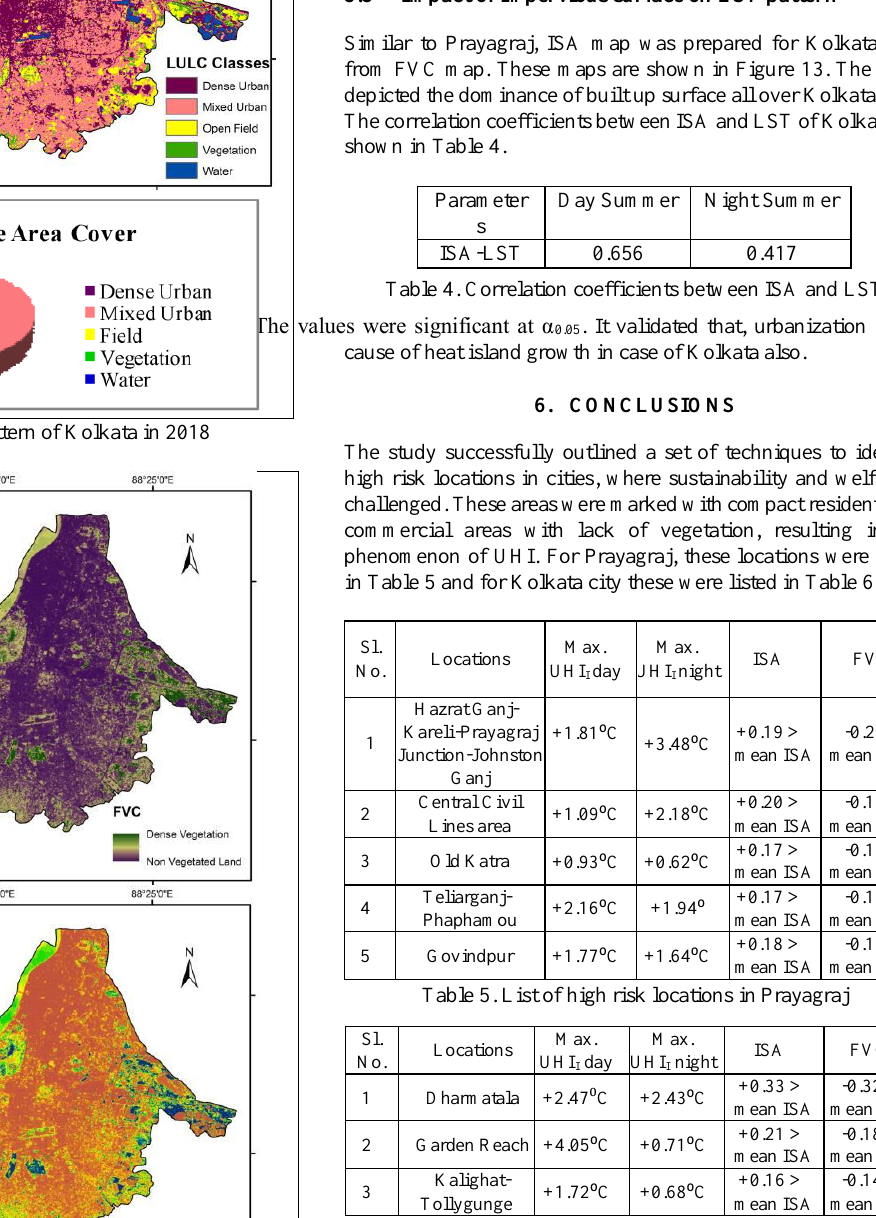
Table 6. List of high risk locations in